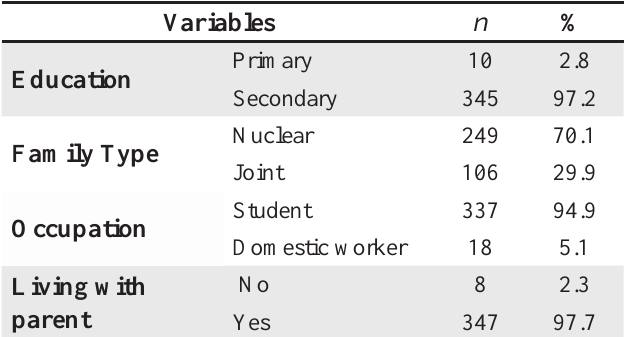
Table 1: Socio-demographic profiles of adolescent girls (N=355)